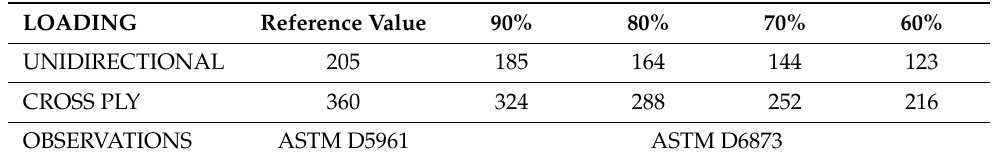
Table 2. Maximum bearing stresses in cyclic tests (all values in